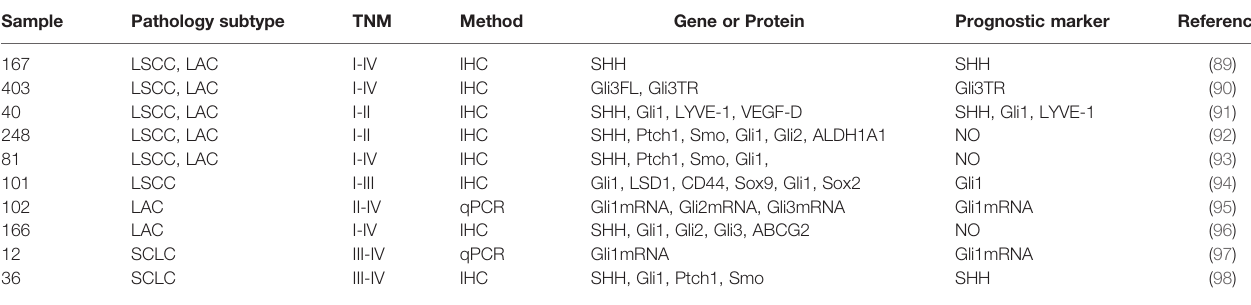
TABLE 1 | The correlation between HH signaling proteins and the prognosis of lung